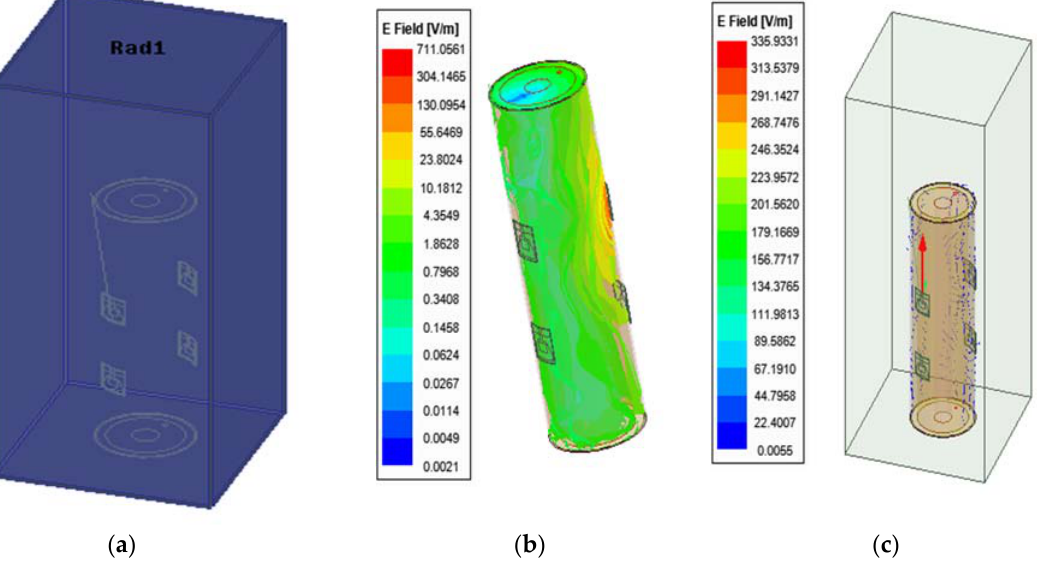
Figure 13. Phantom boundary conditions: ( a ) absorbing boundaries; ( b ) Simulated total electric field strength at the absorbing conditions; ( c ) scattering electric field strength at the absorbing conditions.